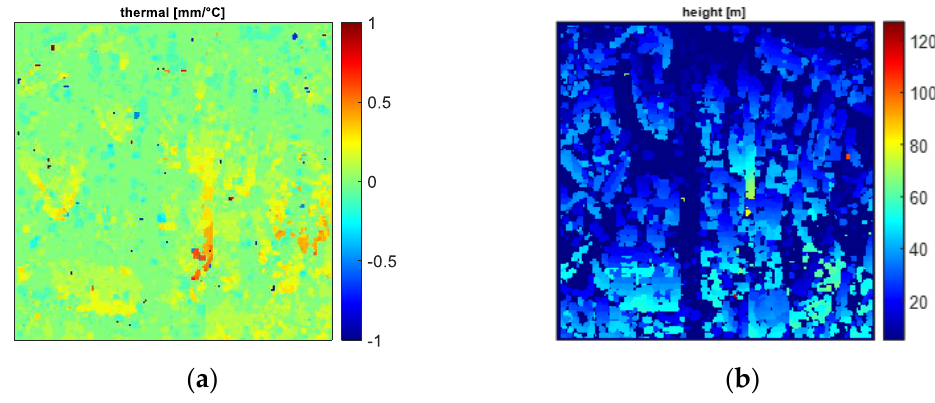
Figure 9. ( a ) MGLRT thermal dilation map with a patch 3 × 3, ( b ) MGLRT height map with a patch 3 × 3 without considering thermal dilation.